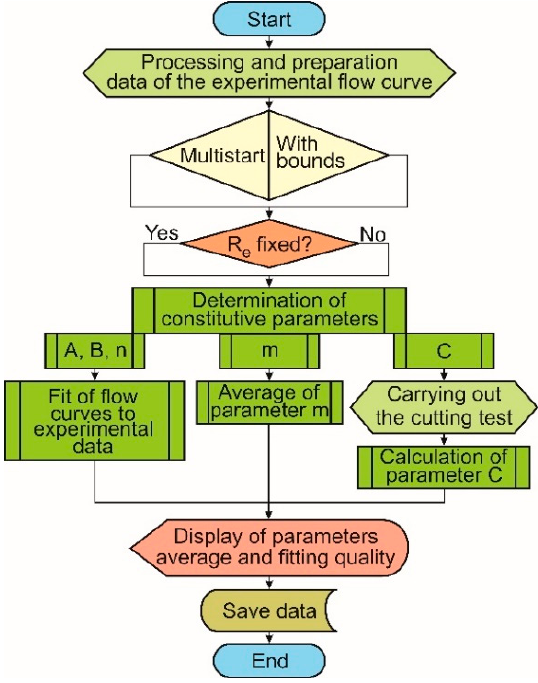
Figure 8. Flow chart of algorithm for the separate determination of constitutive parameters.